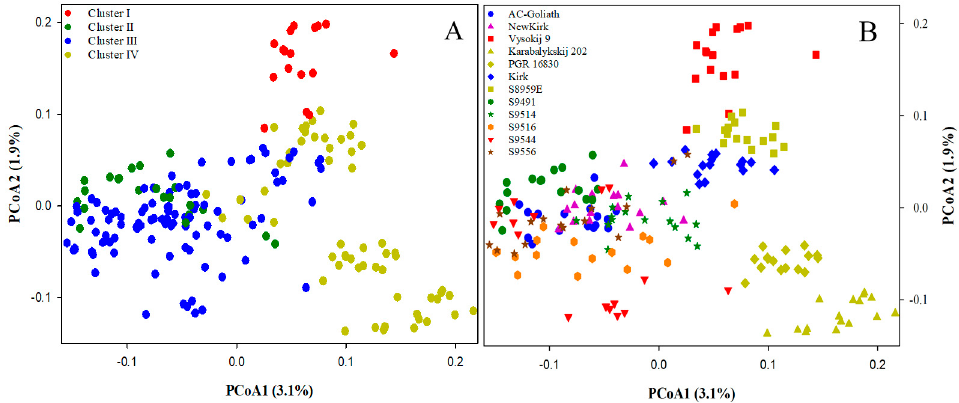
Figure 4. Genetic relationship of 192 genotypes of the 12 crested wheatgrass lines as revealed by principal coordinates analysis (PCoA) with the 45,507 SNP markers. Two panels are identical, but in the left panel ( A) each genotype is labelled with colored circles representing the clusters obtained from the STRUCTURE analysis, while the right panel ( B) labels genotypes for 12 lines.